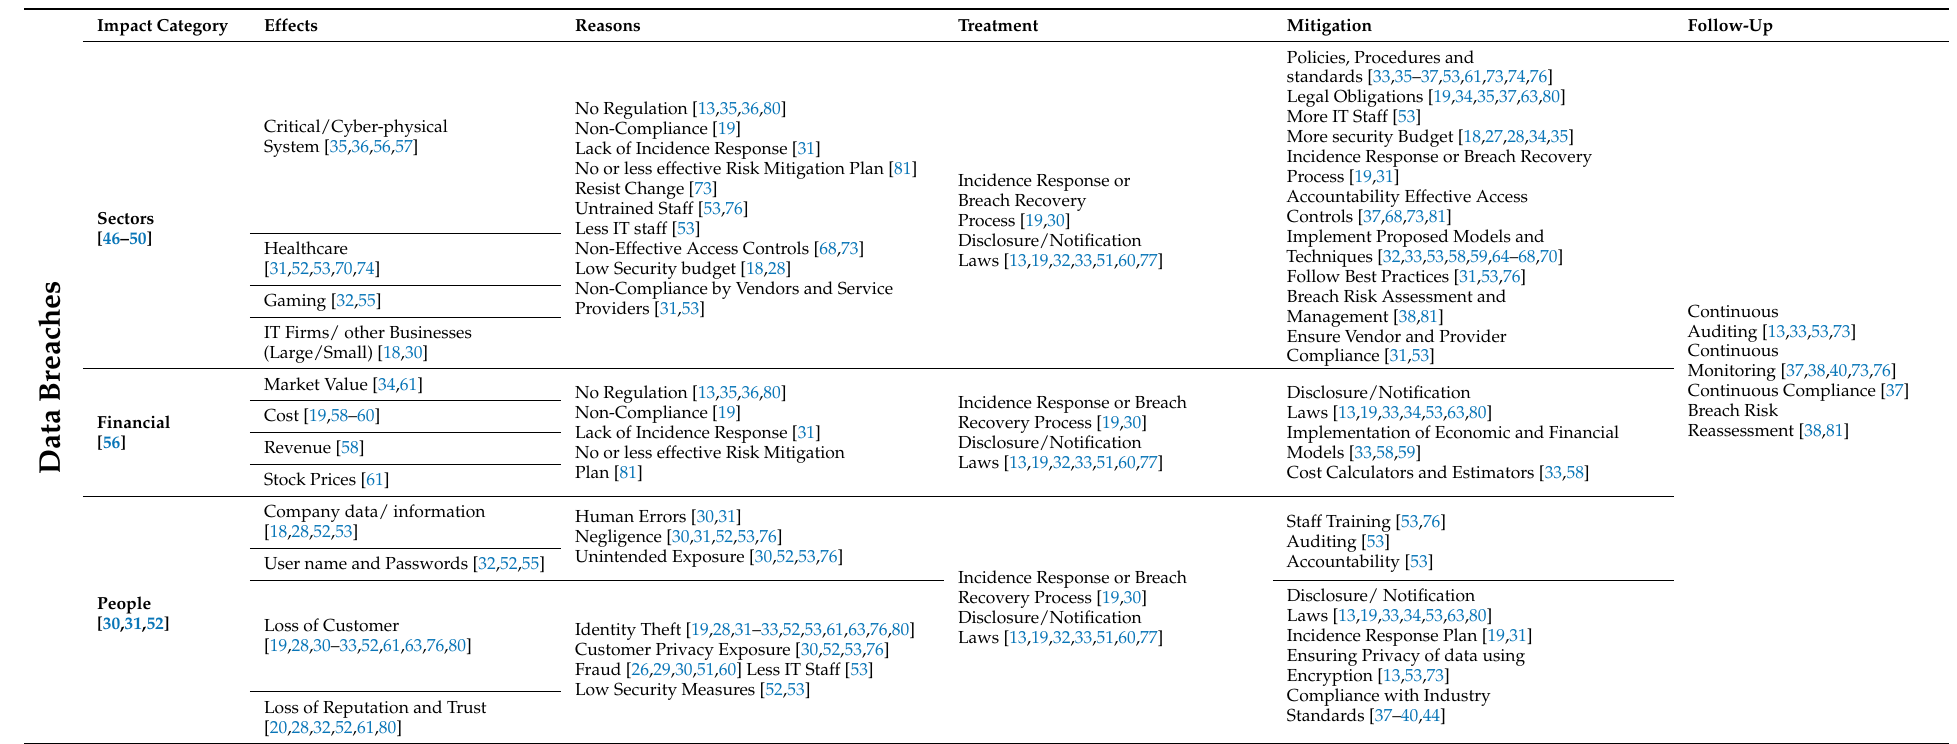
Table 7. Data breaches’ impact and prevention